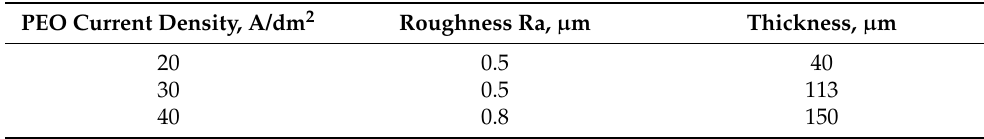
Table 1. The thickness and roughness of PEO